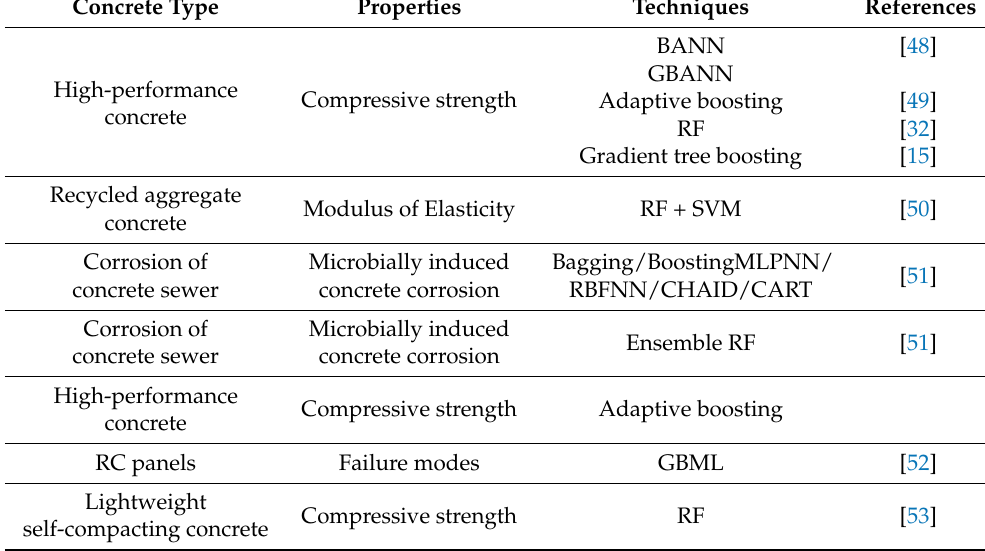
Table 2. Ensemble ML algorithms used in the